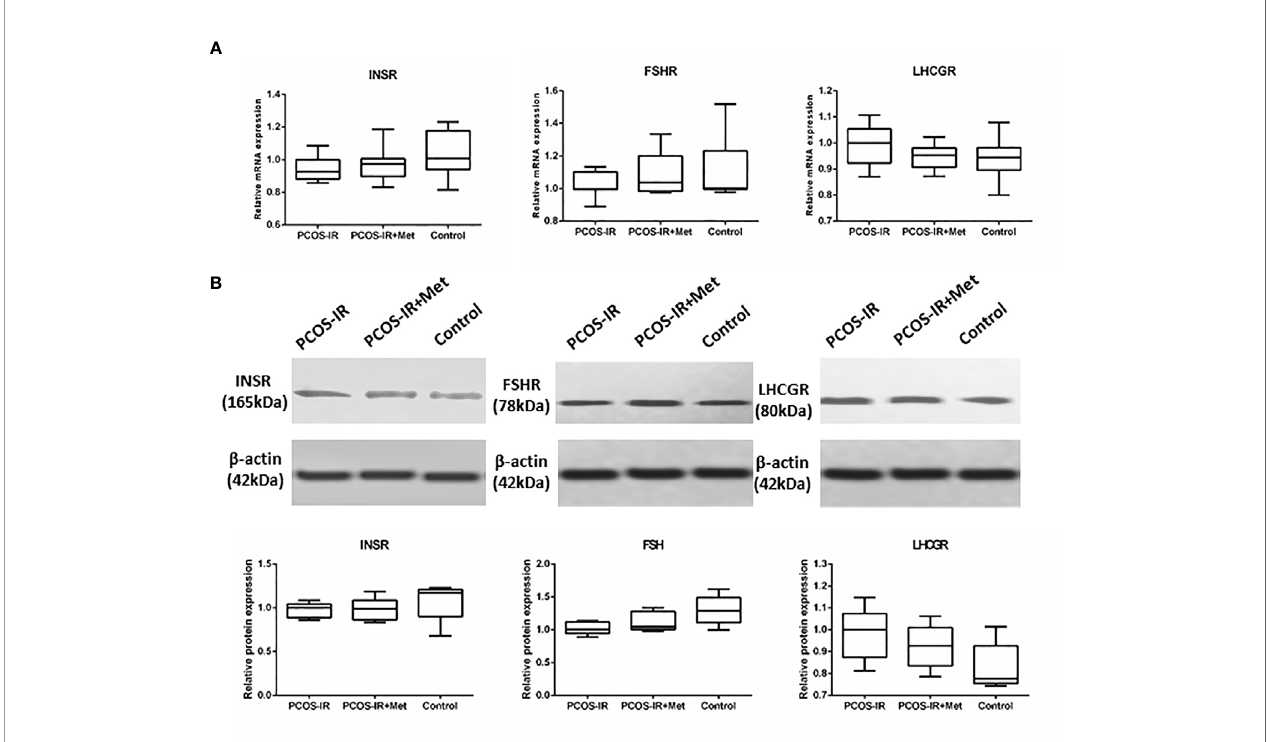
FIGURE 6 | The effects of metformin on INSR, FSHR, and LHCGR expressions in female F2 offspring. (A) INSR mRNA expression in pancreas, FSHR and LHCGR mRNA expression in ovaries following treatment with metformin or placebo as measured by RT-qPCR (PCOS-IR group, n = 9; PCOS-IR+Met group, n = 10; Control group, n = 10). (B) INSR protein expression in pancreas, FSHR and LHCGR protein expression in ovaries following treatment with metformin or placebo as measured by Western Blotting (PCOS-IR group, n = 5; PCOS-IR+Met group, n = 5; Control group, n = 5). The values were shown as the means±SD. There were no signi fi cant changes during those